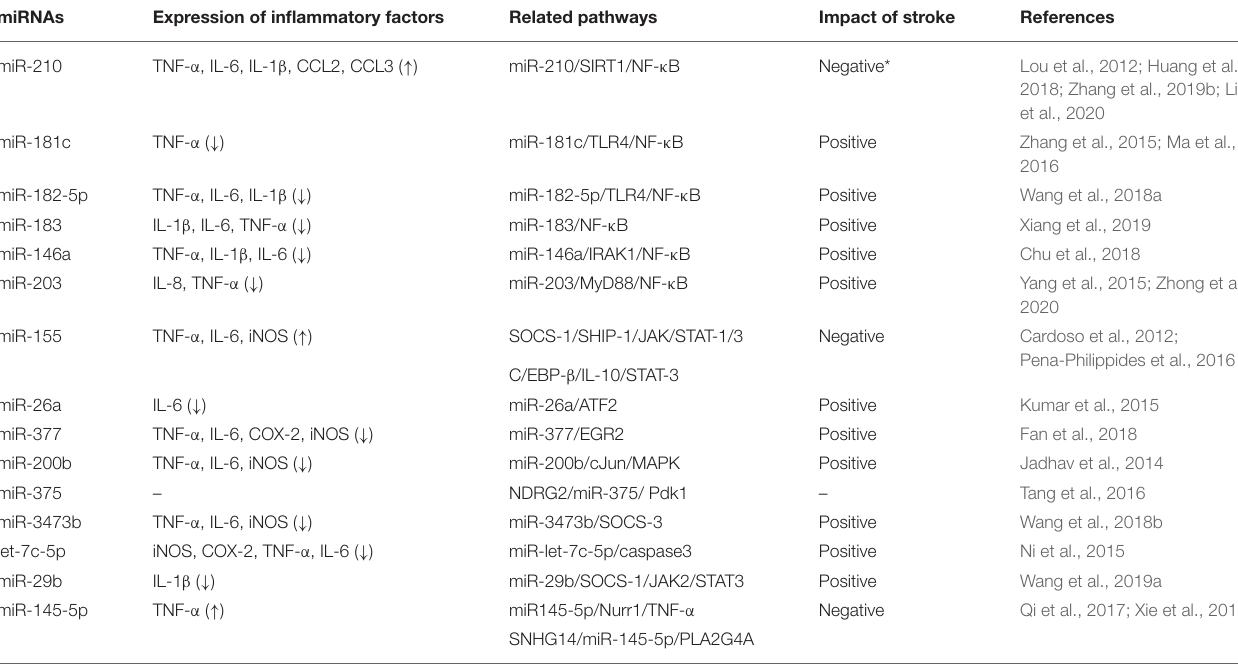
TABLE 1 | Relationship between miRNAs and microglia related neuroinflammation in ischemic stroke. miRNAs Expression of inflammatory